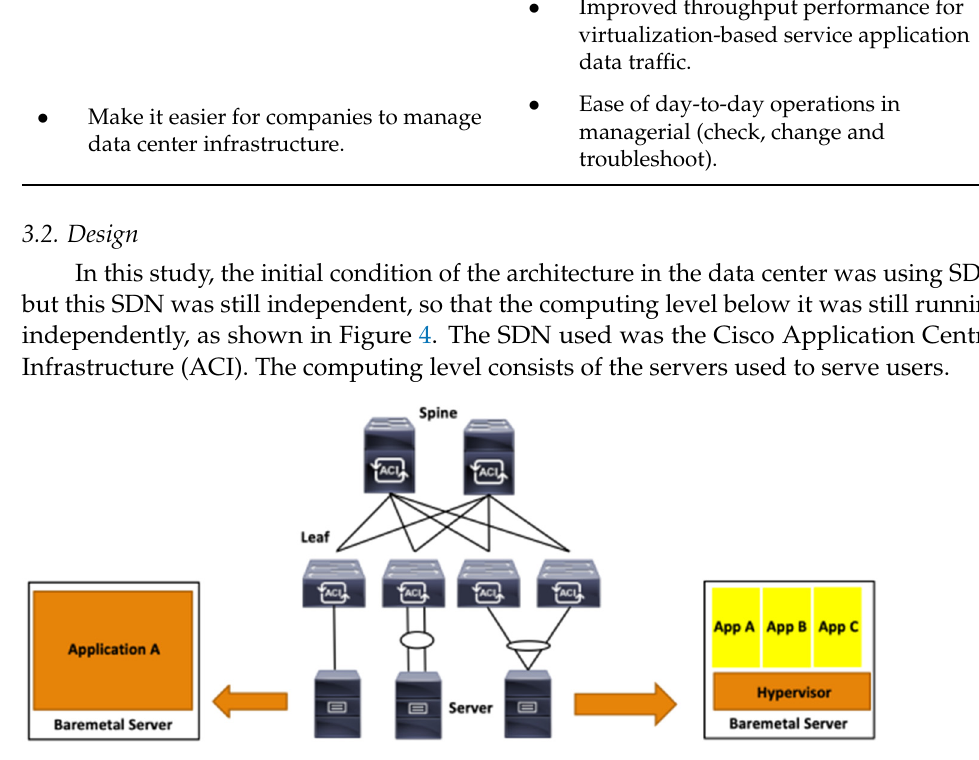
Figure 4. Independent SDN and computing system.